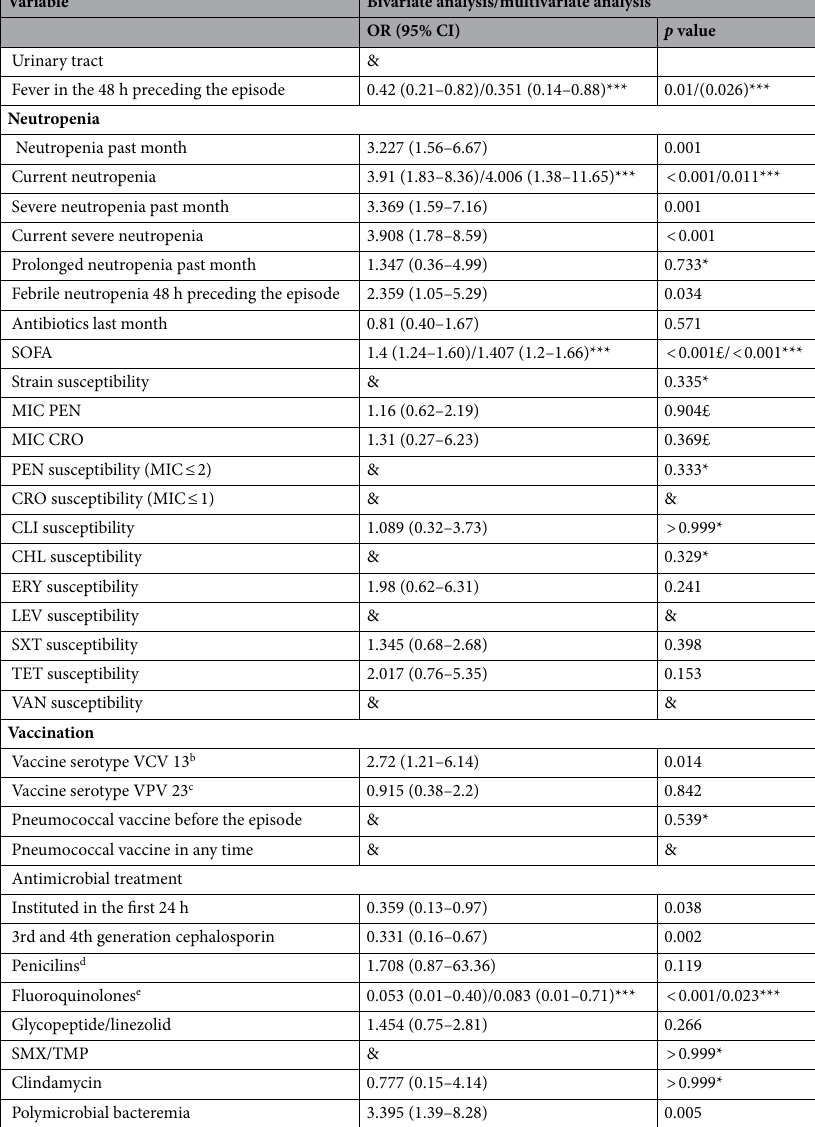
Table 4. Factors potentially associated with 10-day mortality according to characteristics evaluated and results of bivariate and multivariate tests in 161 episodes of bacteremia caused by Streptococcus pneumoniae in cancer patients. Chi-square test; *Fisher exact test; # likelihood ratio test; **T-Student Test; £ Mann–Whitney Test; & Cannot estimate; ***Multiple logistic regression. COPD chronic obstructive pulmonary disease, GTI gastrointestinal tract (esophagus, stomach, small intestine, colon, anus and rectum), SST skin and soft tissue, PEN penicillin, CRO ceftriaxone, CLO chloramphenicol, ERY erythromycin, CLI clindamycin, VAN vancomycin, LEV levofloxacin, SXT trimethoprim-: sulfamethoxazole, TET tetracycline. a Head and neck, oral cavity, larynx and pharynx. b Vaccine VCV 13, or pneumococcal conjugate vaccine 13. c Vaccine VPV 23. or pneumococcal polysaccharide vaccine 23. d Oxacillin, amoxicillin, piperacillin-tazobactam. e Moxifloxacin, levofloxacin. MIC Minimum inhibitory